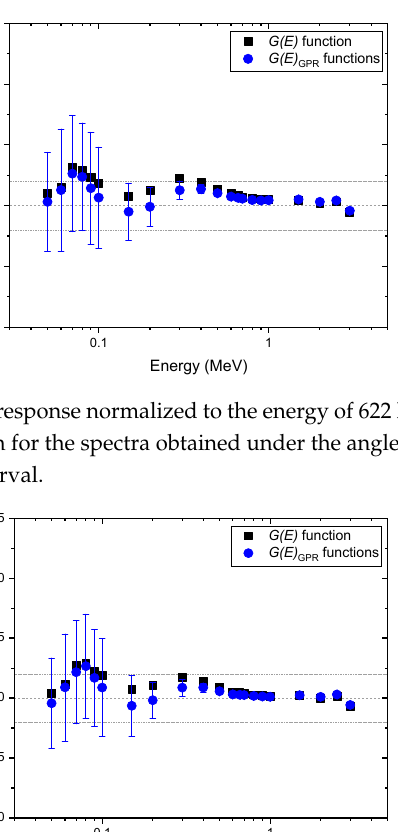
Figure 7. Comparison of energy response normalized to the energy of 622 keV, estimated with (cid:1833)((cid:1831)) (cid:3008)(cid:3017)(cid:3019) functions, and the G(E) (cid:2868)° function for the spectra obtained under the angle of incidence of 45 ° . The error bar shows a 95% confidence interval.